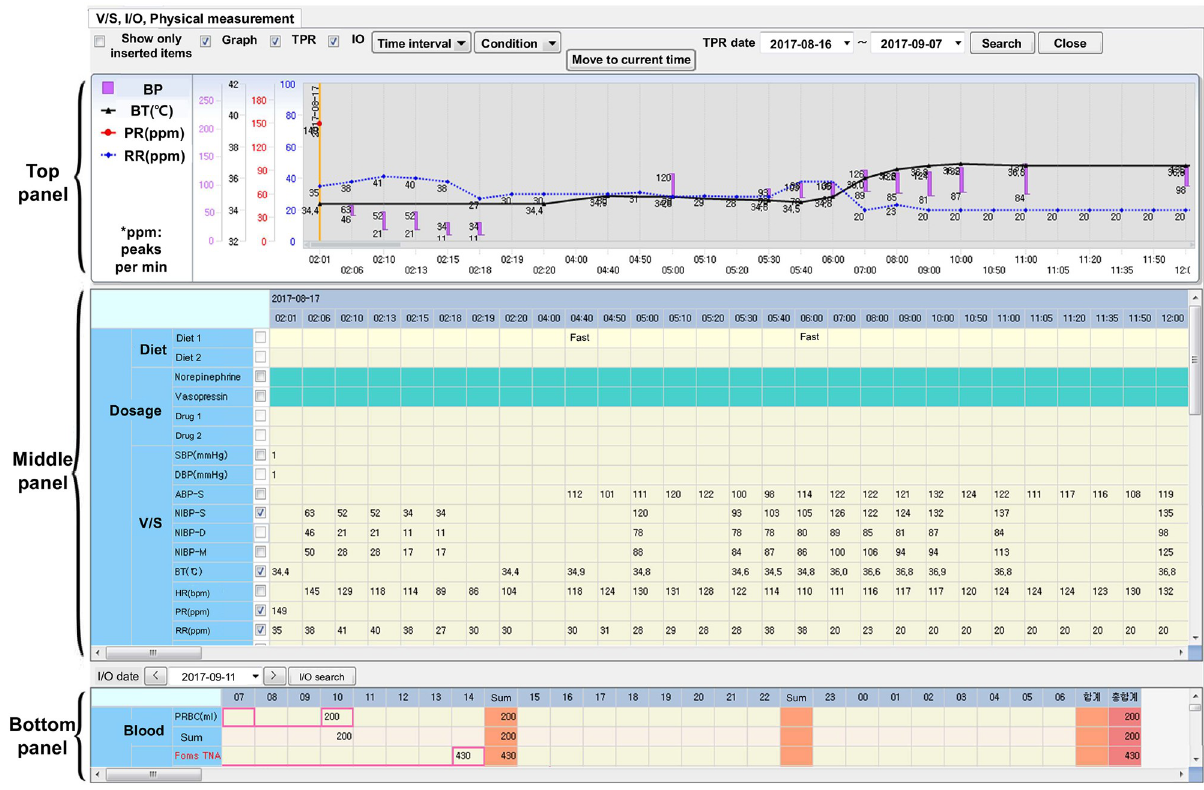
Fig 1. The Electronic Medical Record (EMR) interface system currently being used in our target hospital’s trauma center. This interface consists of three panels: top, middle, and bottom. The top panel plots graphs of a patient’s numerical clinical data shown in the middle panel. The bottom panel displays a patient’s dietary intake information (e.g., meals and